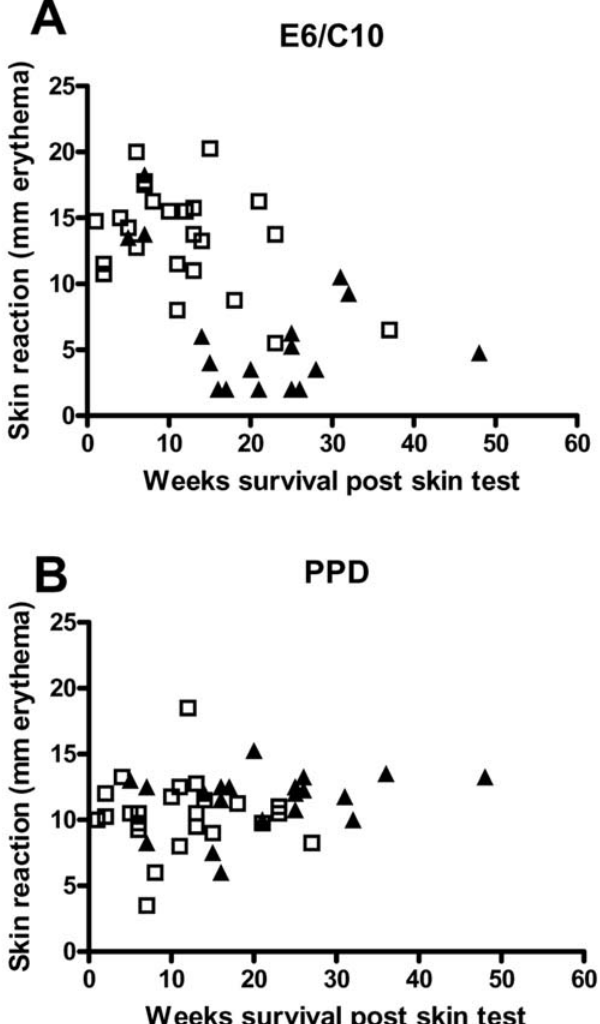
Figure 2. Relationship between disease outcome and skin test response to E6/C10 and PPD. Depicted is the size of the skin test reaction to E6/C10 (figure A) and PPD (figure B) against weeks of survival post skin testing for each animal. Each symbol represents a skin reaction from one animal tested either at week at 4, 8 or 12 weeks post infection (the first skin test for each animal). There is a negative correlation between E6/C10 skin test response and survival time post skin testing (P , 0.0001) but no correlation between PPD responses and survival (P=0.095). Triangles represent data points from BCG vaccinated animals and open squares represent data points from naı¨ve